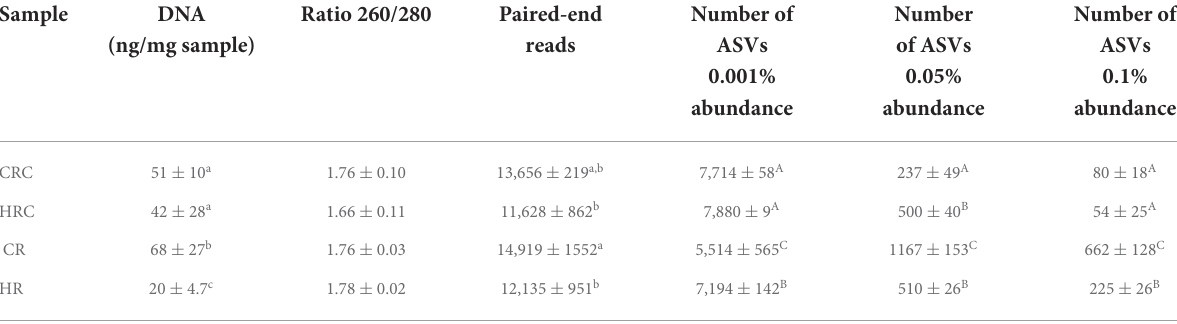
TABLE A1 Illumina MiSeq sequencing summary and amplicon sequencing variants (ASVs) identified per treatment.